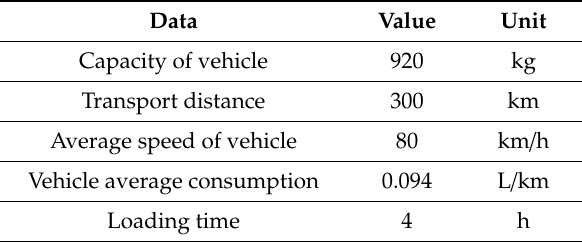
Table A4. Hydrogen Transportation Main Data *.